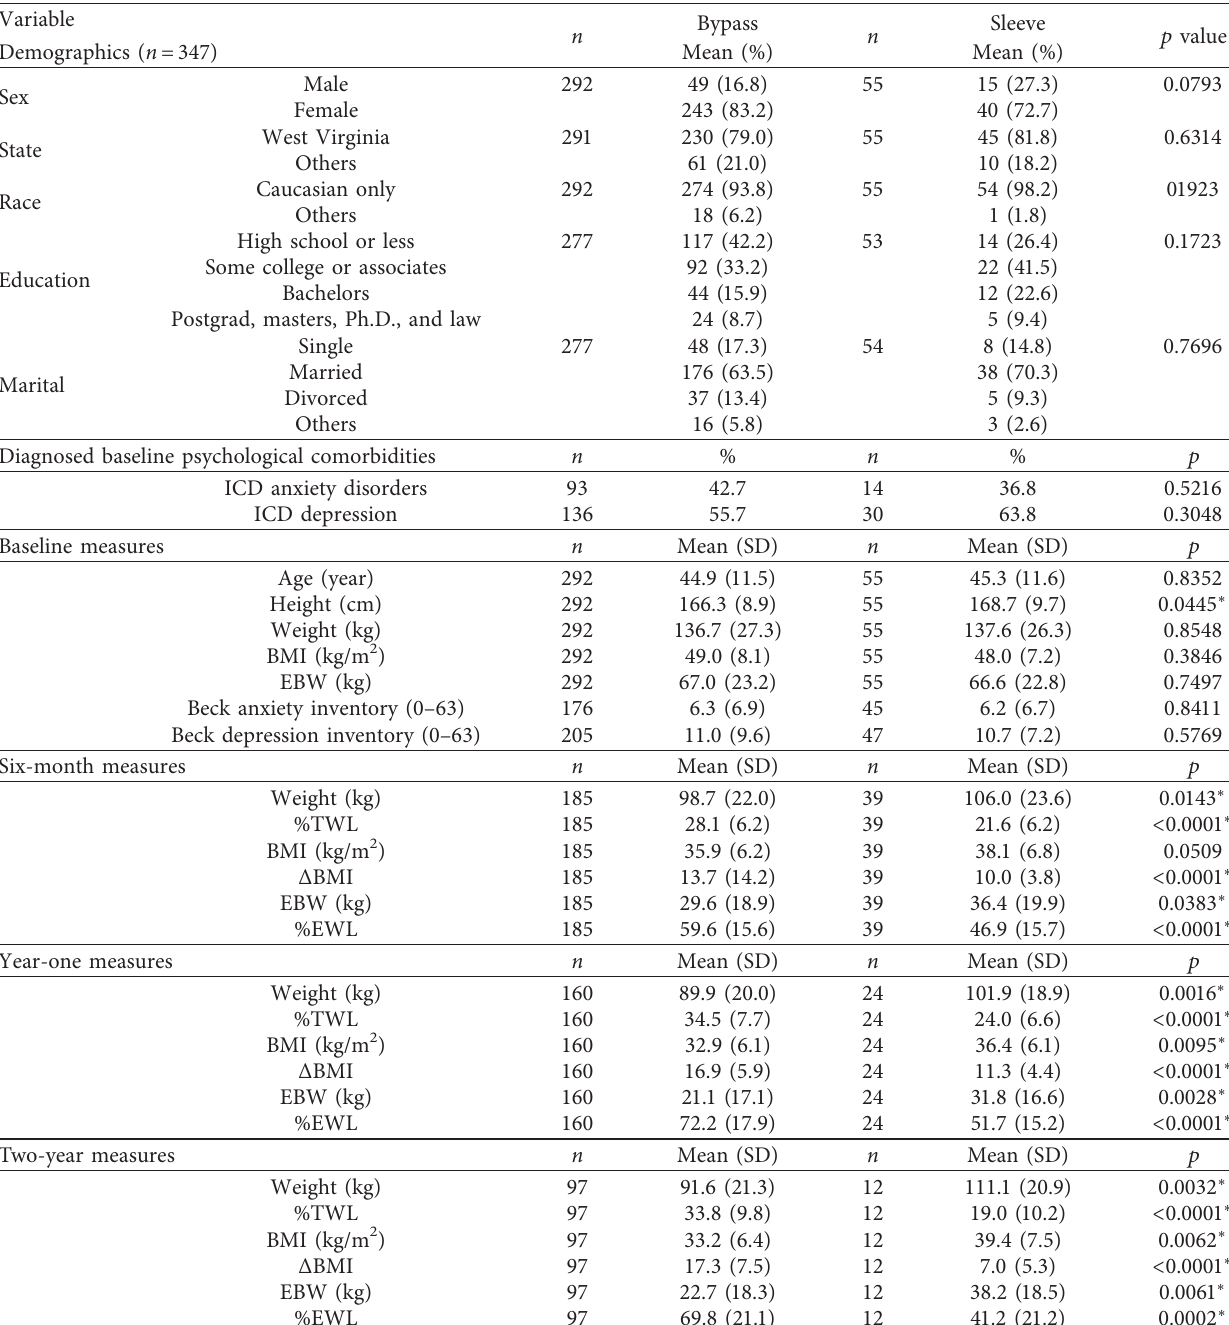
Table 1: Descriptive statistics, by surgery type, of Appalachian bariatric surgery patients between 2013 and 2015 receiving surgery in West